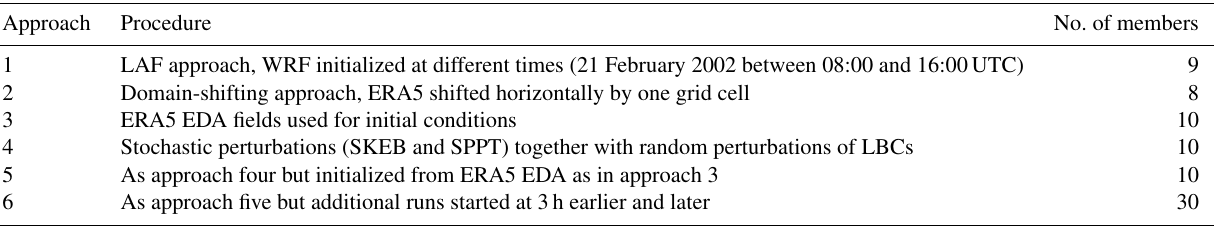
Table 1. Methods tested for the generation of an ensemble hindcast with WRF.